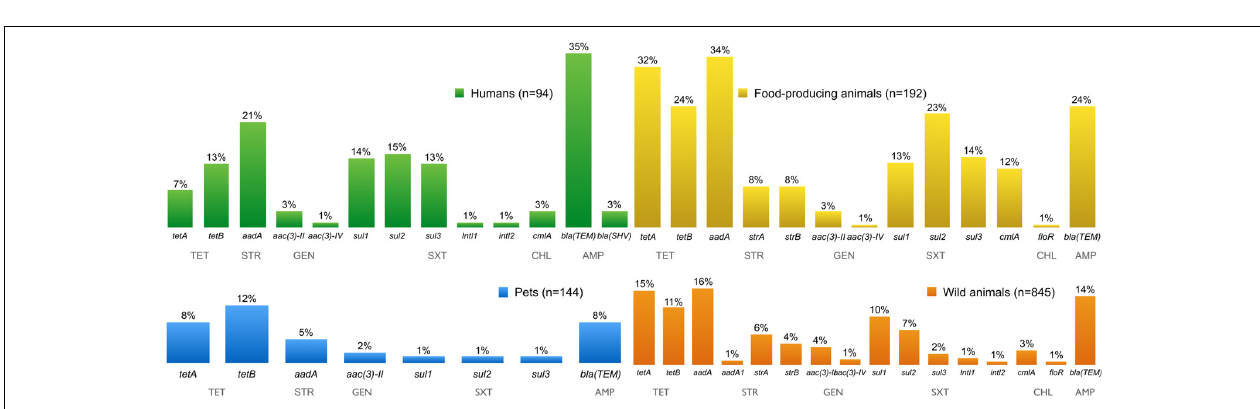
FIGURE 2 | Percentage of phenotypic antibiotic resistance detected in enterococci and E. coli isolates from each of the four sampling groups. The resistance profile of enterococci from food-producing animals is distinct from those of the other sampling groups, showing the highest resistance to tetracycline, streptomycin, trimethoprim-sulfamethoxazole, and chloramphenicol. Enterococci from pets displayed the lowest resistance profile to all tested antibiotics. TET, tetracycline; STR, streptomycin; GEN, gentamicin; NAL, nalidixic acid; CIP, ciproflaxin; SXT, trimethoprim-sulfamethoxazole; CHL, chloramphenicol; AMP, ampicillin.